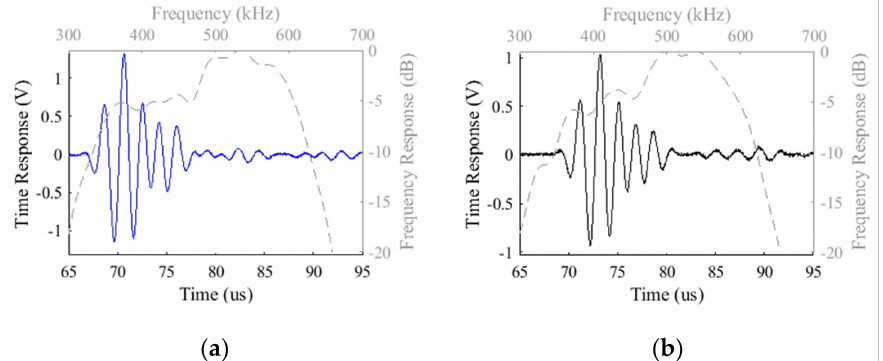
Figure 14. The echoes responses from a central element ( m = 2, n = 3) of ( a ) the transducer T1 (air backing) and ( b ) T2 (epoxy resin backing) excited by a single rectangular negative pulse show that the air backing improves the echo amplitude (the frequency responses of all the elements were normalized to calculate the bandwidth at − 6 dB from the maximum).